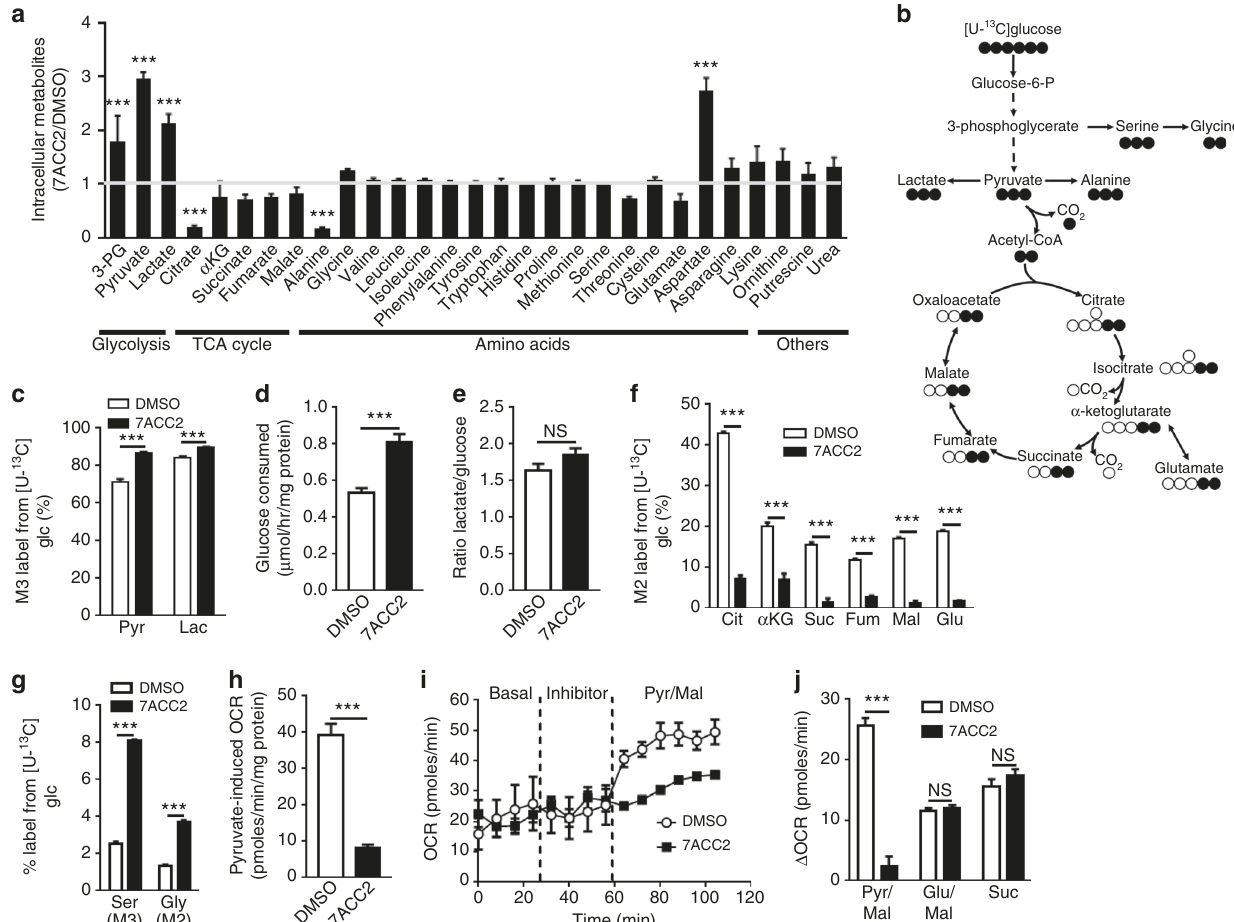
Fig. 3 Inhibition of lactate uptake by 7ACC2 is associated with increased glycolytic fl ux and reduced cell respiration. a Relative abundance of intracellular metabolites in SiHa cells after treatment with 10 µ M 7ACC2 for 24 h. b Carbon atom transition map depicting oxidation of [U- 13 C 6 ]glucose. c Relative abundance of glycolysis-derived pyruvate and lactate, ( d ) glucose consumption, ( e ) lactate/glucose ratio, relative abundance of indicated ( f ) TCA cycle intermediates and ( g ) serine synthesis pathway metabolites in SiHa cells treated or not with 10 µ M 7ACC2 for 24 h. h Pyruvate-dependent OCR in SiHa cells after treatment with 10 µ M 7ACC2. i OCR measurements using isolated SiHa cell mitochondria in response to pyruvate/malate substrates after treatment with 10 µ M 7ACC2 and ( j ) extent of OCR increase in response to indicated substrates. Data are represented as mean ± SEM of three independent experiments (with ≥ 6 technical replicates). Signi fi cance was determined by Student ’ s t -test ( d , e , h ), one-way ANOVA ( a ) or two-way ANOVA ( c , f , g , j ) with Bonferroni multiple-comparison analysis. *** p < 0.001; NS, not signi fi